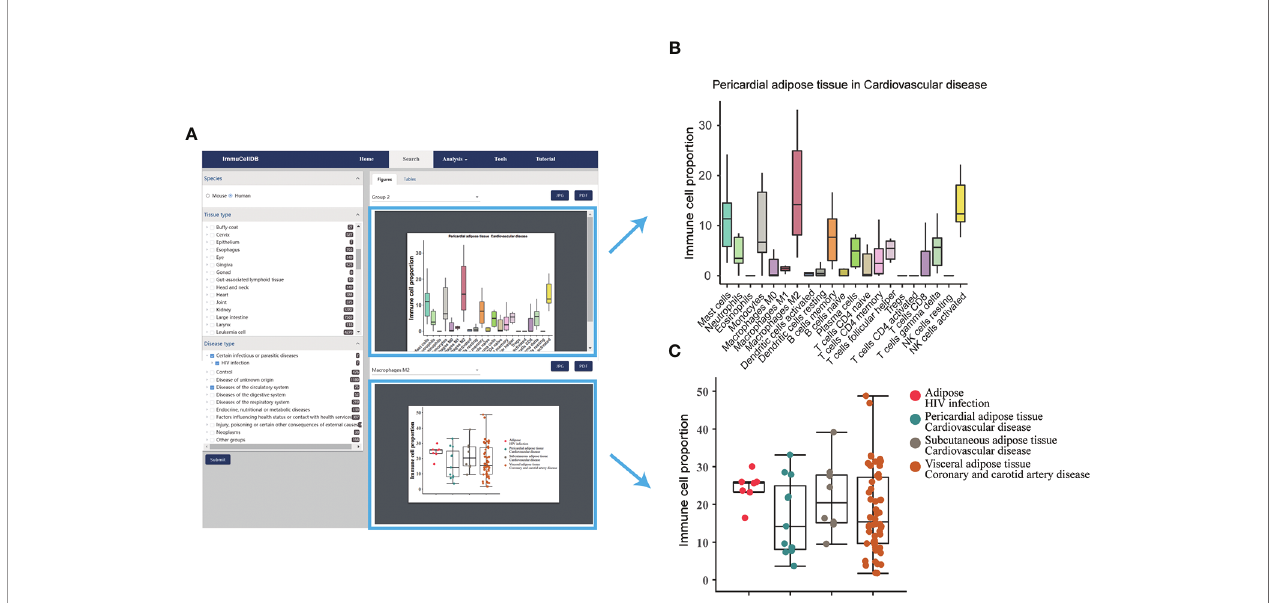
FIGURE 2 | A snapshot for search module. (A) Result page for the search module. The selection box for species, tissues and diseases was located on the left side of this page and all fi gures and tables generated were listed in the right side of this page. (B) Boxplot for the proportions of 21 immune cells under the selected tissue and disease conditions. Notably, only the fi rst 10 tissue and disease condition groups was displayed. (C) Boxplot and dotplot for the proportion of each immune cell type across different conditions. One immune cell type correspondent to one fi